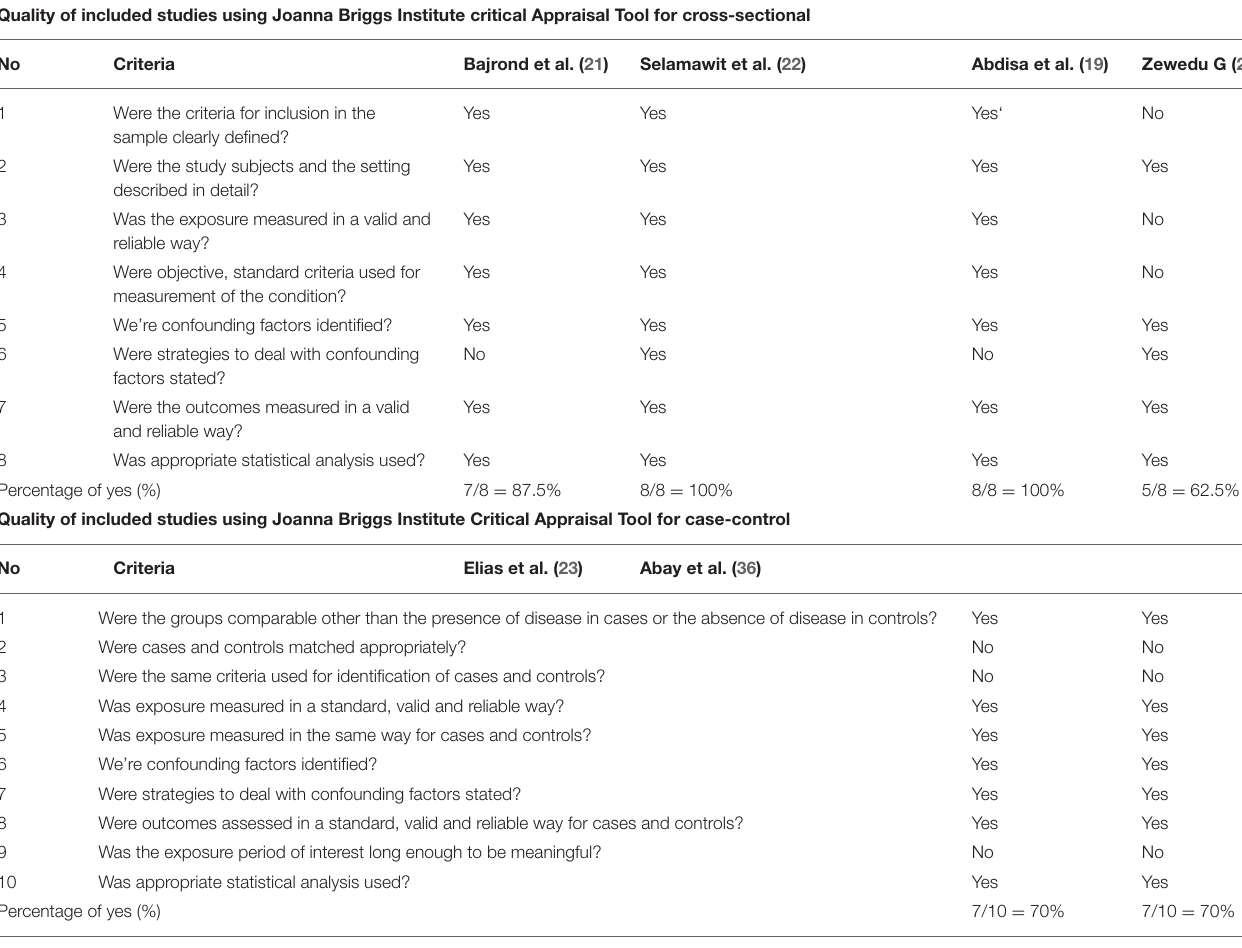
TABLE 2 | Quality of included studies using Joanna Briggs Institute critical Appraisal Tool for cross-sectional, case-control, and prospective cohort. No